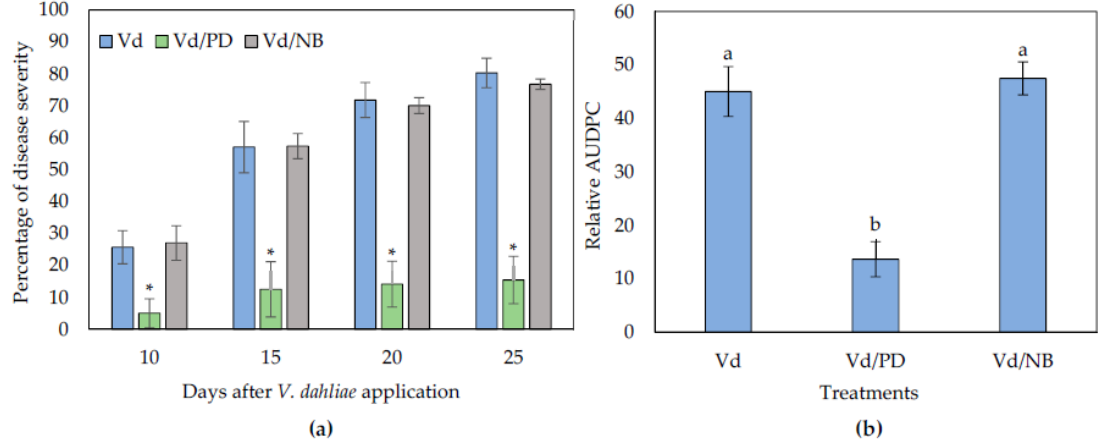
Figure 3. Verticillium disease severity ( a ) and relative AUDPC ( b ), caused by artificial inoculation of V. dahliae (Vd), on eggplants grown in autoclaved soil substrate amended with PD and NB. Each treatment consisted of 10 plants and the experiment was repeated three times. Columns represent means of the three replications ( n = 30 plants) and the vertical bars indicate standard errors. For disease severity ( a ), columns with asterisks (*) are significantly different ( p < 0.01) from control (Vd) according to t -test, for each time point; for relative AUDPC ( b ), columns with different letters are significantly different ( p < 0.05) from each other according to LSD test.